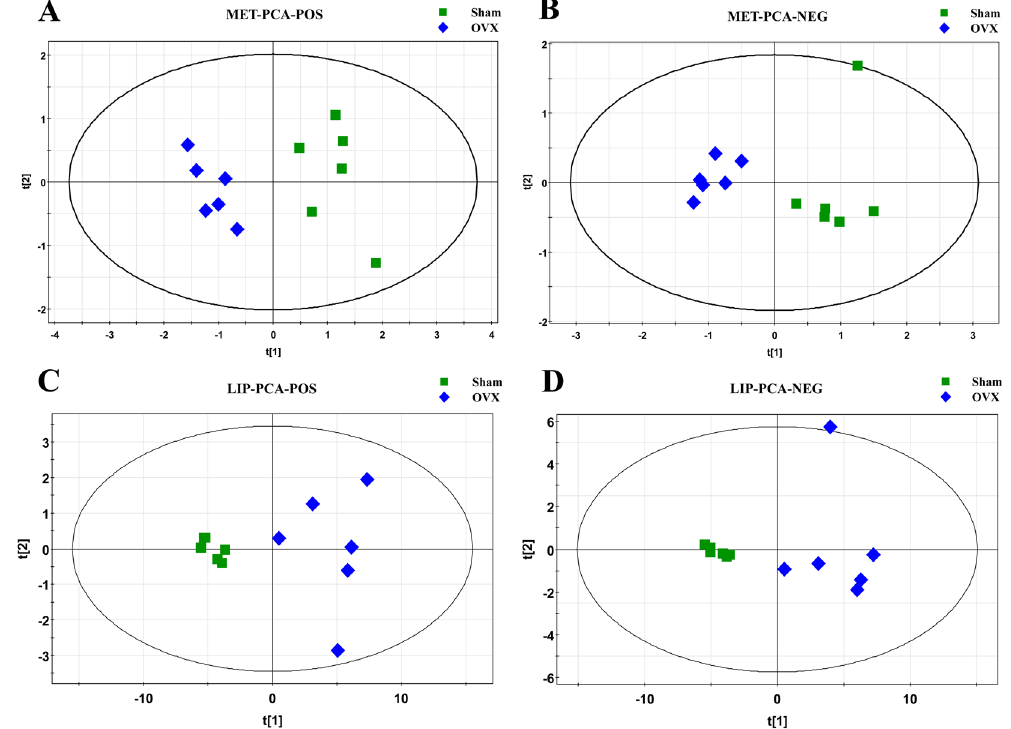
Figure 4. PCA score plot of multivariate statistical analysis of the experimental group in ESI positive and negative ion mode. ( A , B ) PCA score plot of the sham and OVX group in ESI positive and negative ion mode respectively in metabolomic analysis; ( C , D ) PCA score plot of the sham and OVX group in ESI positive and negative ion mode respectively in lipidomic